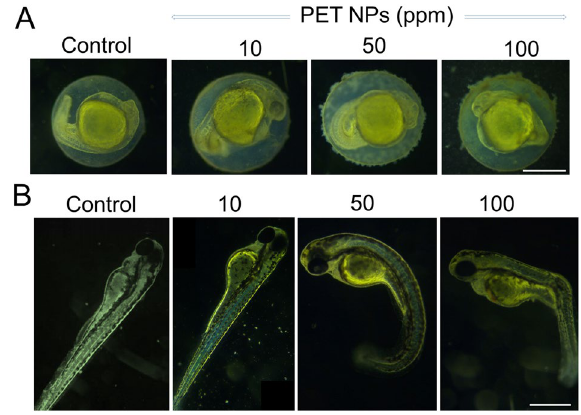
Figure 3. Representative images showing the effect of PET NPs on early stages of zebrafish embryo development. Embryos (6 hpf) were treated with different concentrations of PET NPs (0, 10, 50 and 100 ppm) for 24 h ( A ) and 72 h ( B ). After 72 h exposure to 100 ppm PET NPs, approximately 6–8% of the embryos show deformities including malformation of lateral curvature in spine similar to scoliosis, bending of the tail and bending of the body after treatment with PET. Scale bar: 0.5 mm in ( A ) and 1 mm in ( B